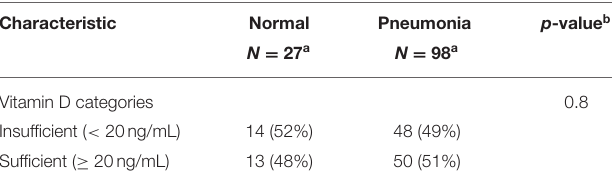
TABLE 8 | The association between serum 25(OH)D levels (sufficient, deficient) and radiological findings of the patients. Characteristic Normal Pneumonia p -value b N = 27 a N = 98 a Vitamin D categories